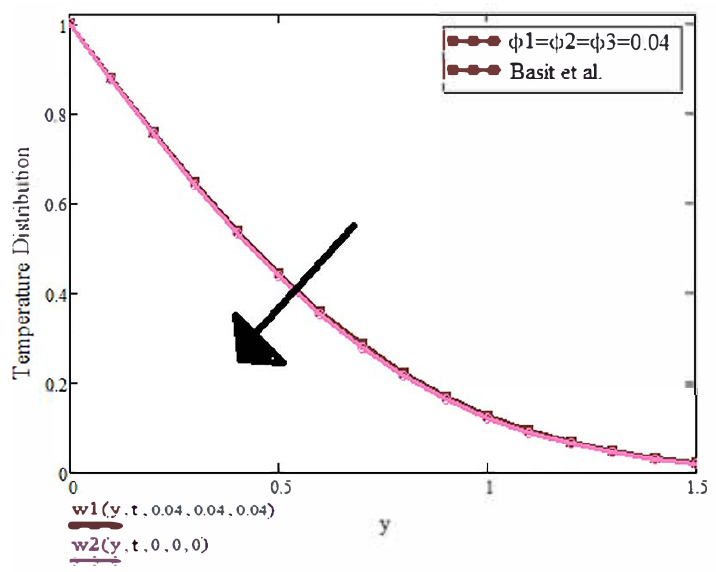
Figure 10. T ( y , t ) with φ 1 , φ 2 , φ 3 when t = 1.3, a = 0.4, λ = 1, Pr = 6.2, β 1 = 0.9 [2].